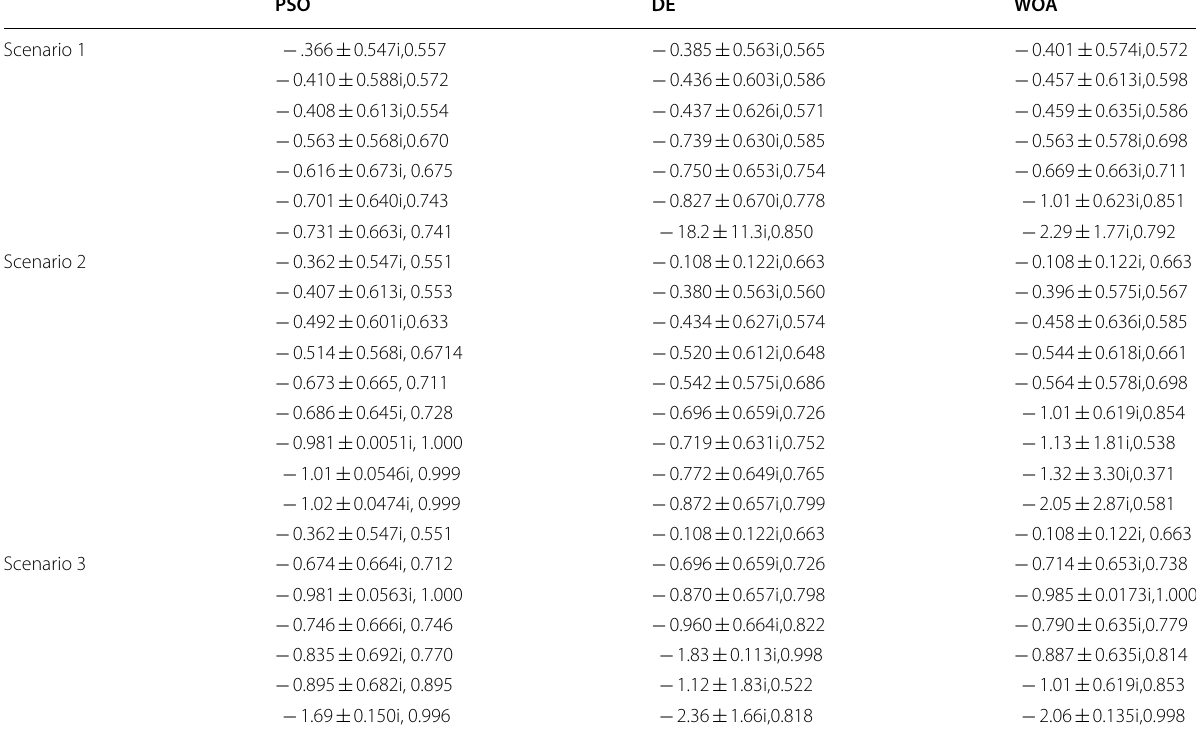
Table 10 Eigenvalue analysis of three